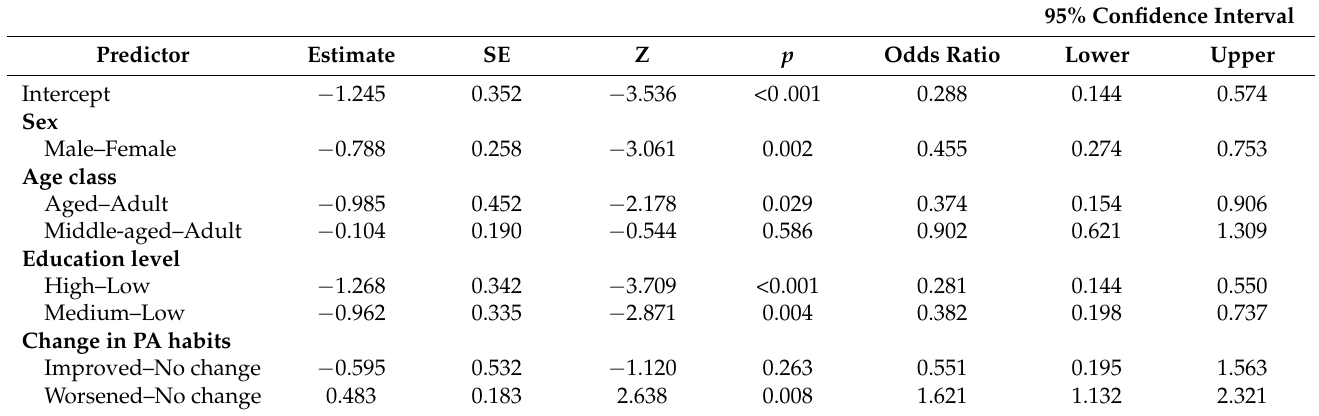
Table A2. Results of Multivariate Regression Analysis Models, with Quality of Sleep as Dependent Variable and Change in PA Habits and Sociodemographic Characteristics as Independent